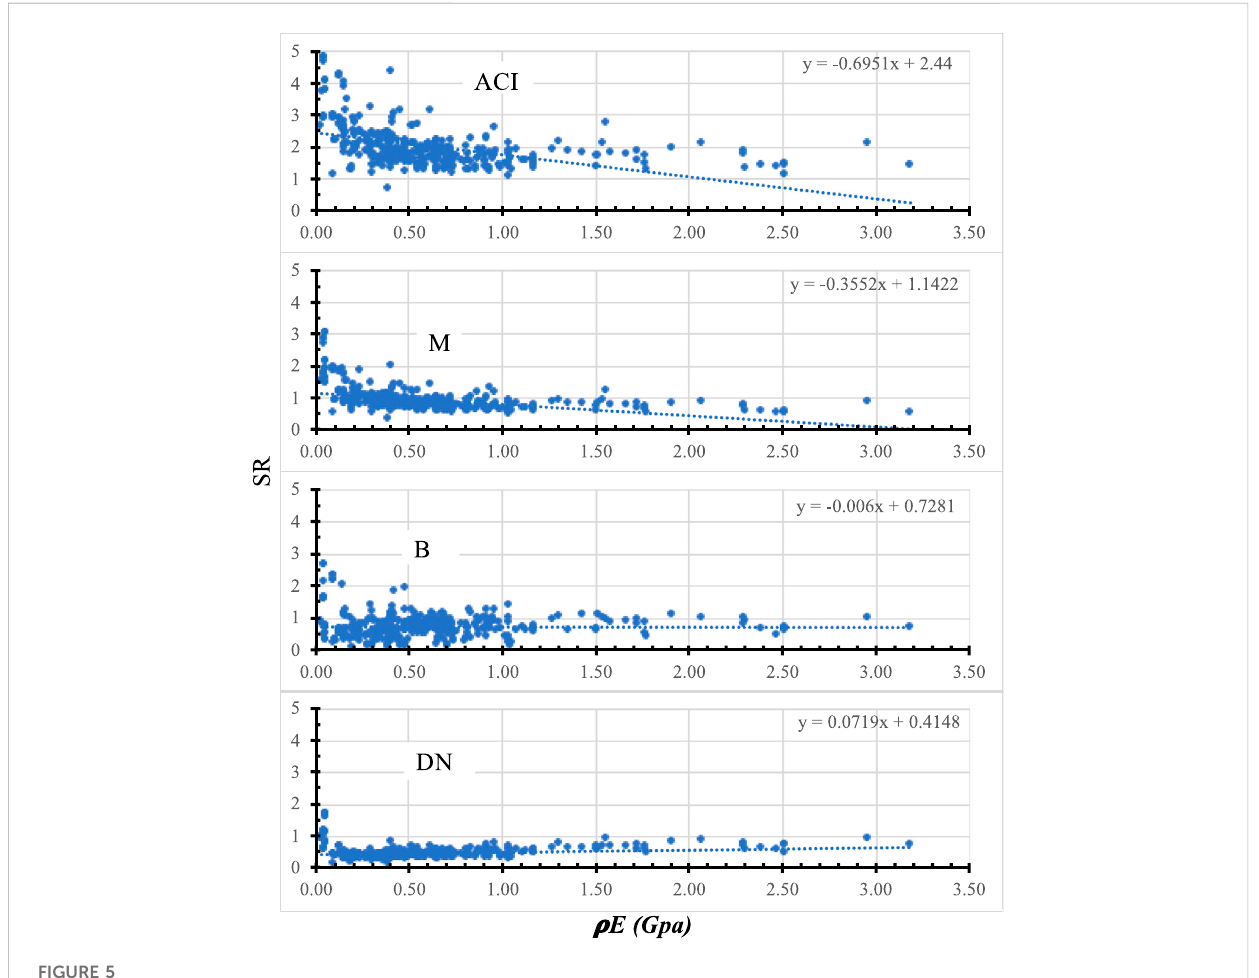
FIGURE 5 SR calculated using selected model versus fl exure reinforcement axial